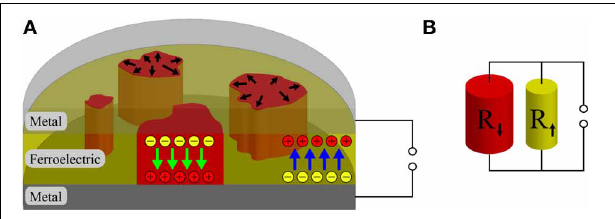
FIGURE 4 | (A) A schematic cross section of the ferroelectric layer with visible domains. The red areas inside the sketch visualize the domains with pointing down polarization, marked by green arrows. The bright yellow area is the “unswitched” area and defined by polarization pointing up (blue arrows). The black arrows indicate the growth direction of the ferroelectric domains with opposite polarity. (B) Simplifying (A) to a model of parallel connected resistances, where R ↑ is the summarized resistance of areas with polarization up and R ↓ with polarization down